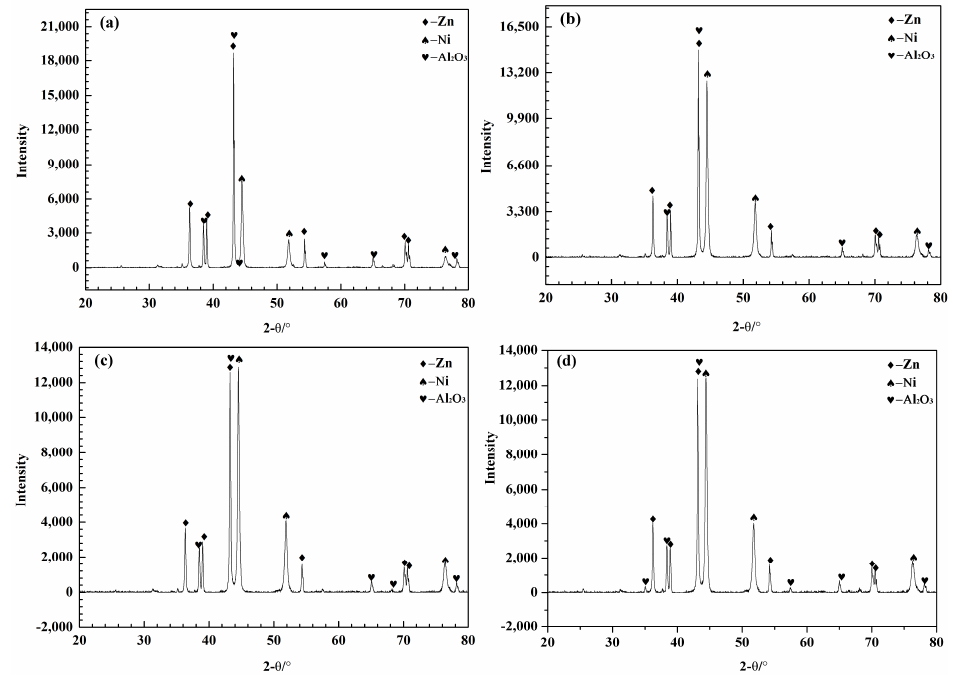
Figure 6. XRD patterns of the composite coatings with different Ni powder contents ( a ) 10 wt %, ( b ) 15 wt %, ( c ) 20 wt % and ( d ) 25 wt %. Table 2. EDS analysis of LPCS Zn-Ni composite coatings.